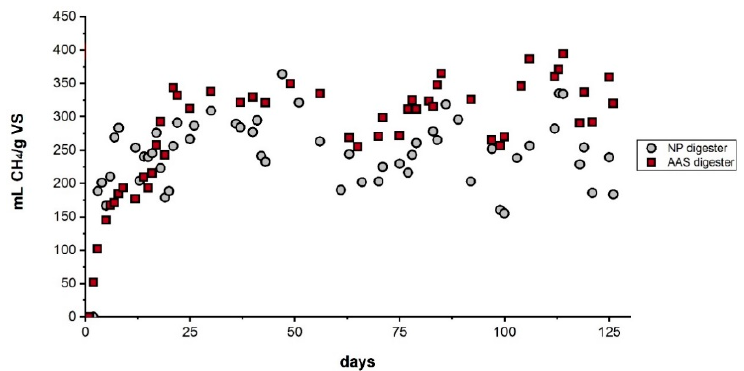
Figure 1. Methane yield of digesters NP (fed with manure and NP fibers) and AAS (fed with manure and AAS-treated fibers) during the entire period of experiments.